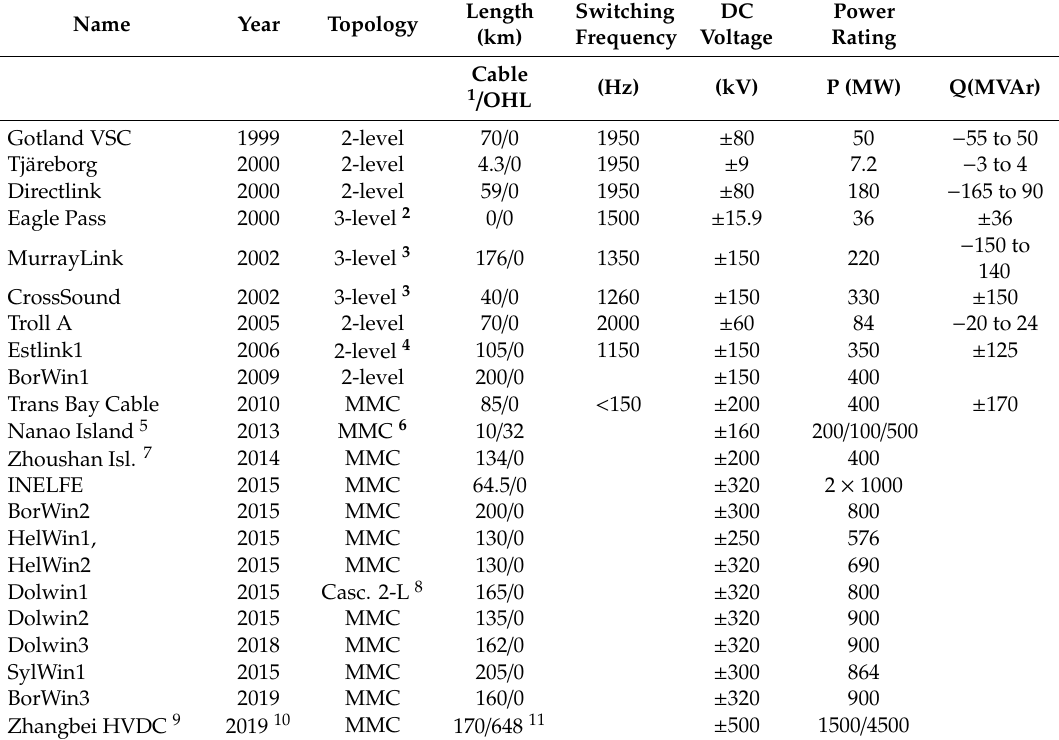
Table 3. Selected HVDC Schemes using Voltage Source Converters